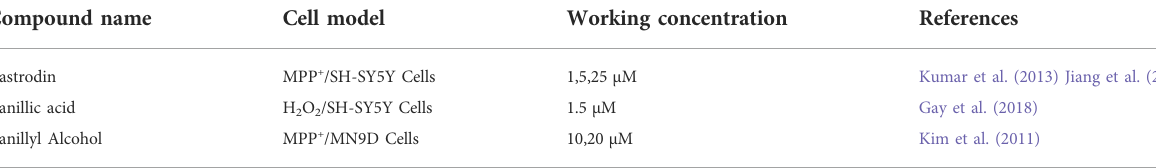
TABLE 2 The working concentration of anti-apoptosis of Tianma compounds in cell models.